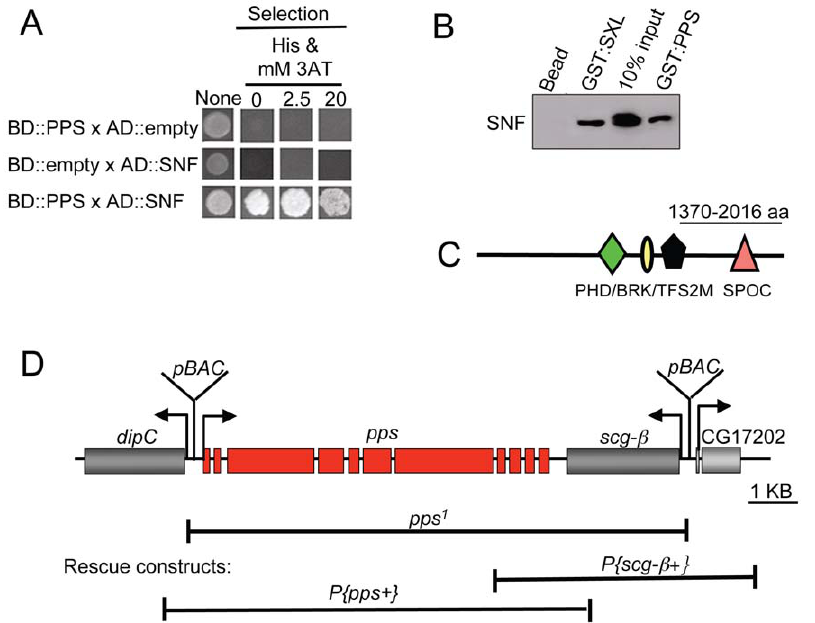
Figure 1. PPS, a large multidomain protein, is a SNF interacting protein. (A) Yeast two-hybrid interactions between PPS and SNF. Positive interactions were tested by assaying the ability of the transformed yeast to grow on selective media after 3 days. (B) PPS/SNF complex assembly tested by GST pull-down assays in whole cell extracts. The lane marked 10% input is a control in which the amount of extract corresponds to 10% of the material applied to the glutathione affinity beads. (C) Diagram of the 2016 amino acid PPS protein. PPS contains 4 conserved motifs, which are drawn approximately to scale. The line above the diagram is the region of the protein used for the yeast two hybrid experiments in (A), in the GST pulls experiments in (B) and for production of the PPS antibody. (D) Genomic organization of PPS and its neighboring genes. Solid boxes represent exons. The position of the insertions used to generate pps 1 is indicated above the diagram. The genomic DNA deleted in pps 1 and the genomic DNA used in the rescue constructs is indicated by a solid line below the